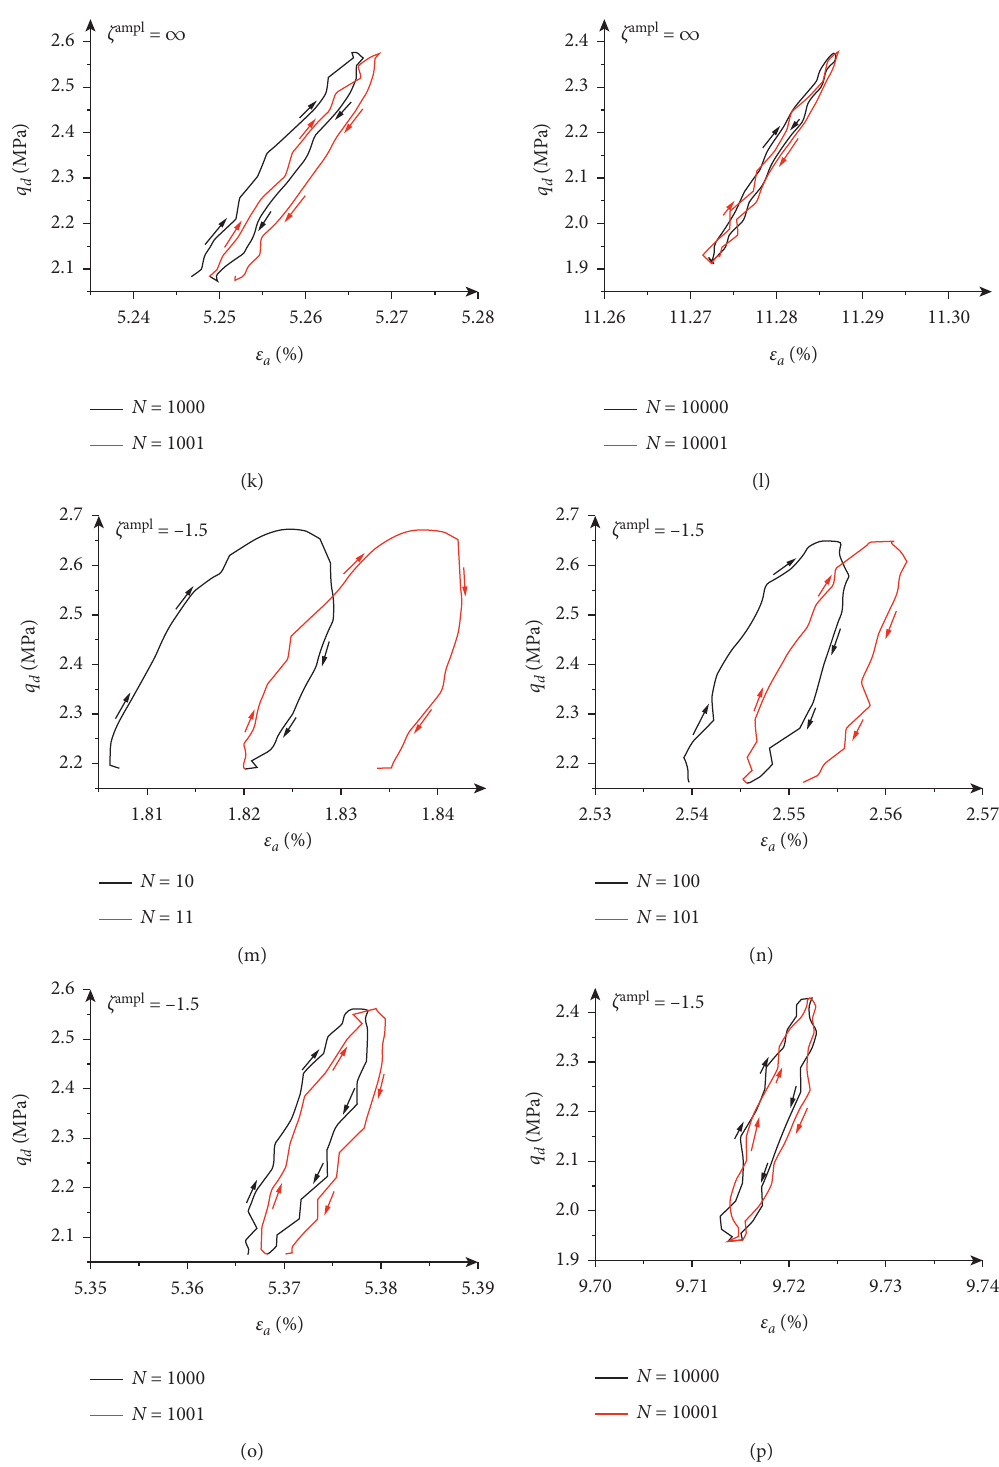
Figure 16: The hysteresis loops with different amplitude ratios under the same amplitude of deviatoric